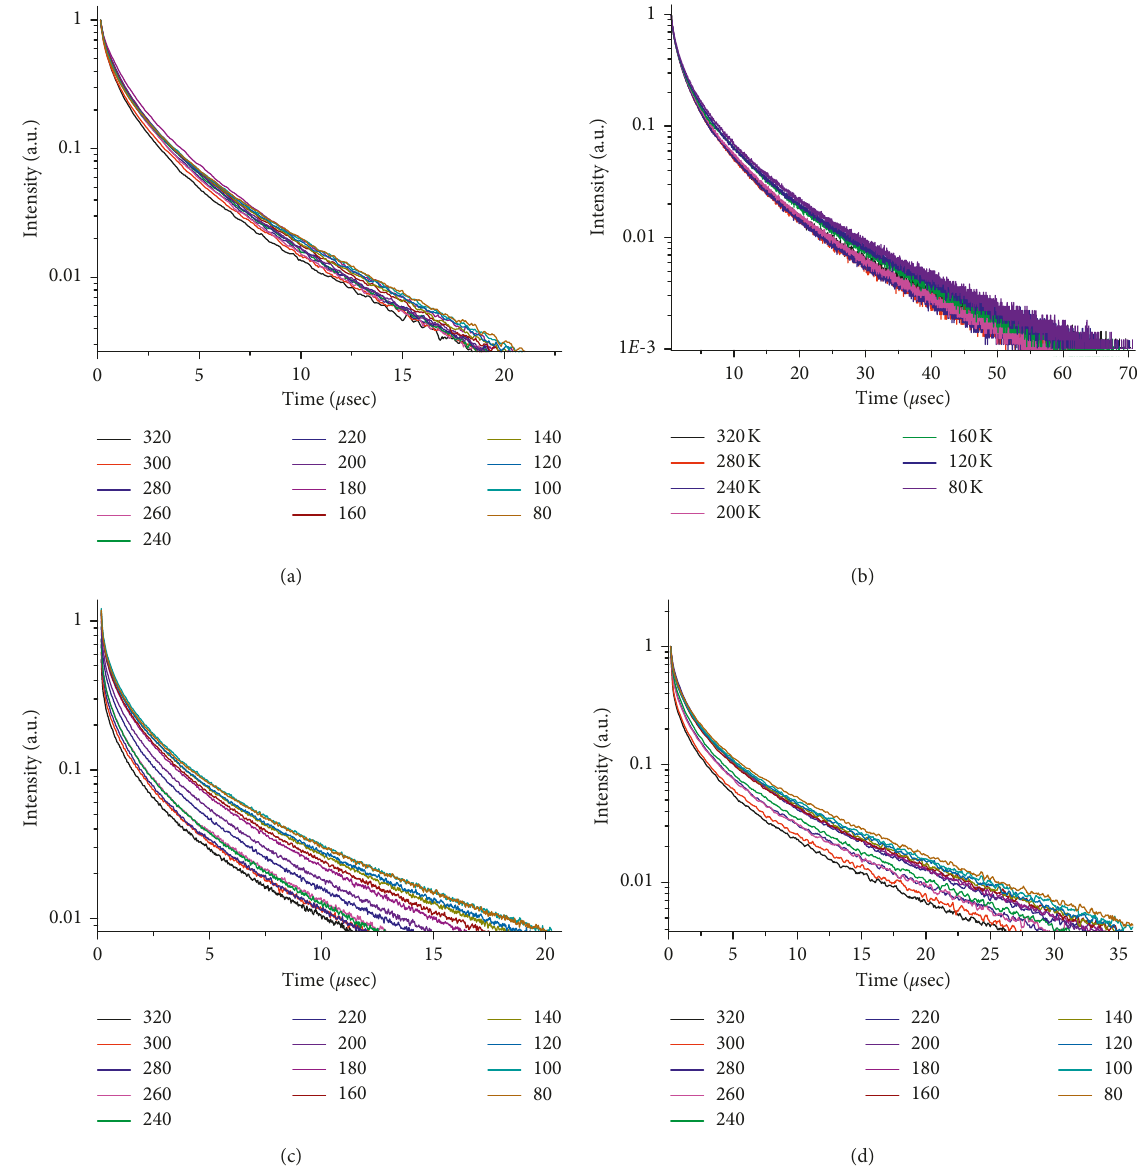
Figure 10: Fluorescence decay curves of 3 P 0 level recorded at different temperatures upon 444nm laser excitation of core nanoplates (a), core/shell nanoplates (b), core nanospheres (c), and core/shell nanospheres